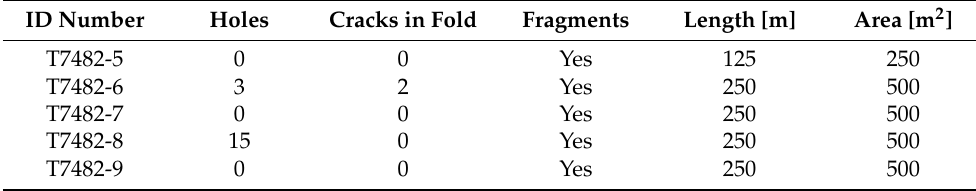
Table 10. Examination of PE